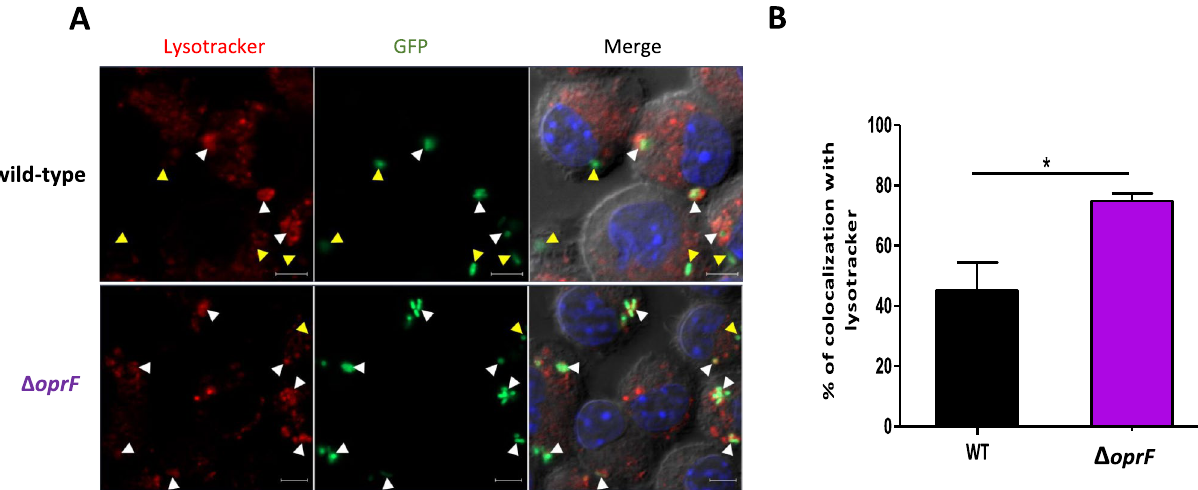
Figure 5. Colocalization of P. aeruginosa with a probe that labels acidic compartments. J774 macrophages were infected with PAO1 and ∆ oprF strains expressing GFP. After 2.5 h of gentamicin treatment,